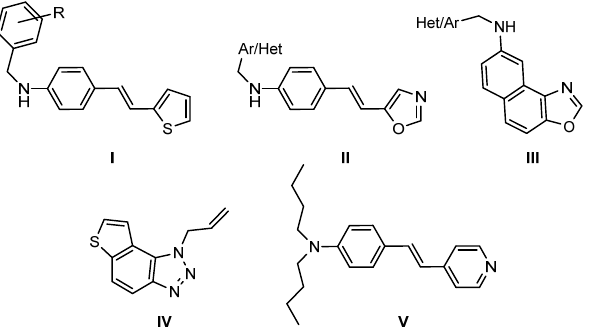
Figure 1. The basic structure of new and known heterostilbenes and their photocyclization products: new amino-thienostilbenes ( I ), amino-oxazolostilbenes ( II ) [27], naphthooxazolo-amines ( III ) [27], and thienobenzo-triazoles ( IV ) [29], as proven active compounds, and amino-styryl organic dye ( V ) [30].